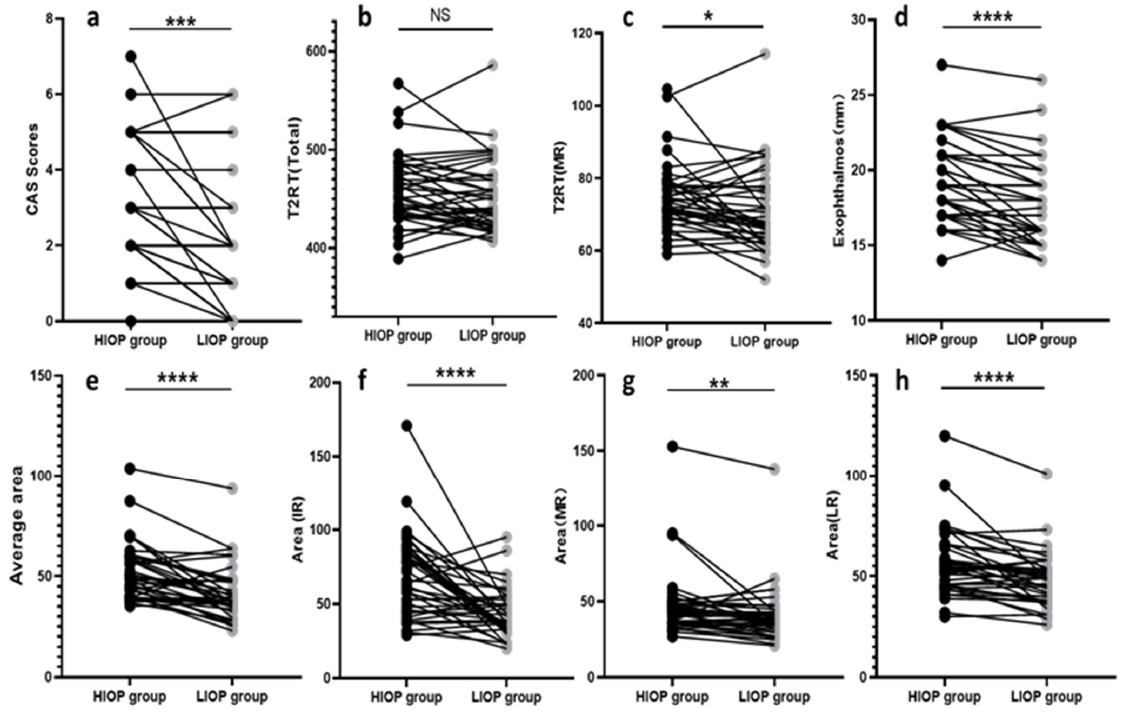
Figure 2. Wilcoxon signed-rank test charts show the differences of the CAS score ( a ), the overall orbital T2 relaxation time—T2RT (Total) ( b ), the medial rectus muscle T2 relaxation time—T2RT(MR) ( c ), exophthalmos ( d ), the average extraocular muscle cross-sectional area—average area ( e ), the inferior rectus cross-sectional area-area (IR) ( f ), the medial rectus cross-sectional area—area (MR) ( g ), and the lateral rectus cross-sectional area—area(LR) ( h ) between the HIOP and LIOP groups. CAS, clinical activity score; T2RT, T2 relaxation time; MR, medial rectus; IR, inferior rectus; LR, lateral rectus; HIOP, high intraocular pressure; LIOP, low intraocular pressure; NS, not statistically different; * p < 0.05; ** p < 0.01; *** p < 0.001; **** p < 0.0001.